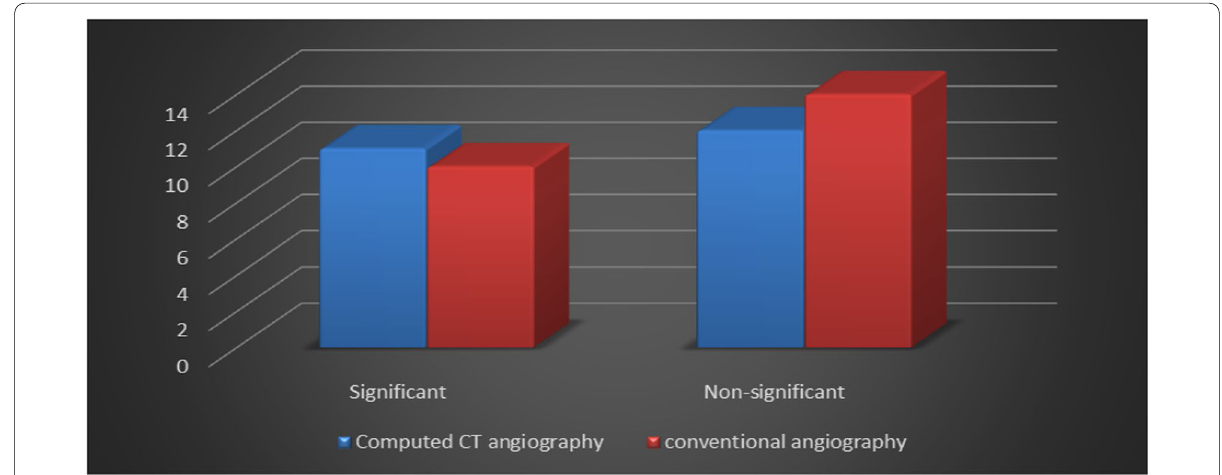
Fig. 5 Comparison between the computed tomography (CT) coronary angiography by using “coronary artery disease—reporting and data system (CAD-RADS)” and the conventional coronary angiography in all patients (per-patient